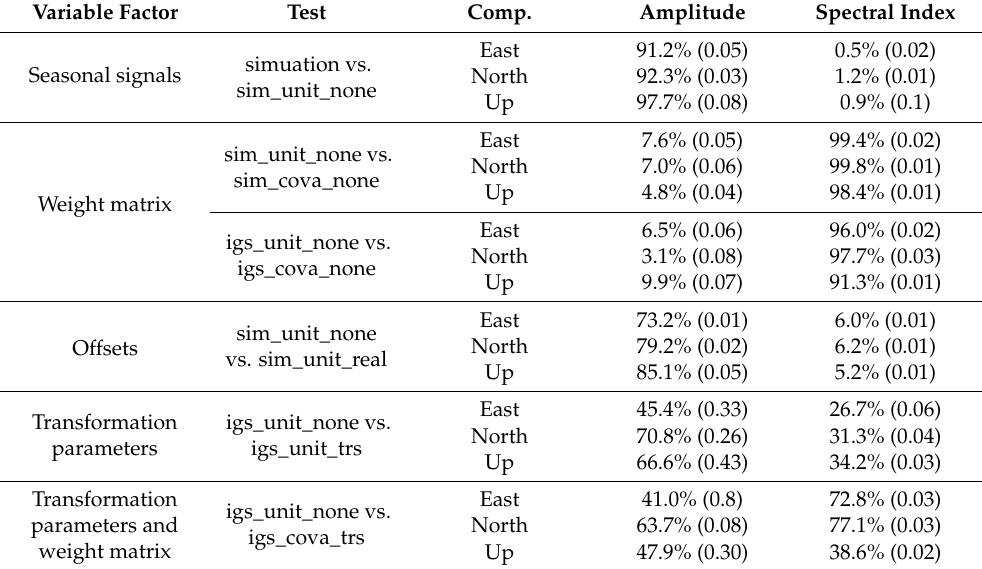
Table 3. Effects of different variable factors on the noise analyses for the residuals of stacking solutions with different strategies. The columns of “Amplitude” and “Spectral Index” list the percentage of stations with smaller or lower values for the latter solution in column “Test”. The values in the parenthesis are the medians of absolute difference between the two solutions in column